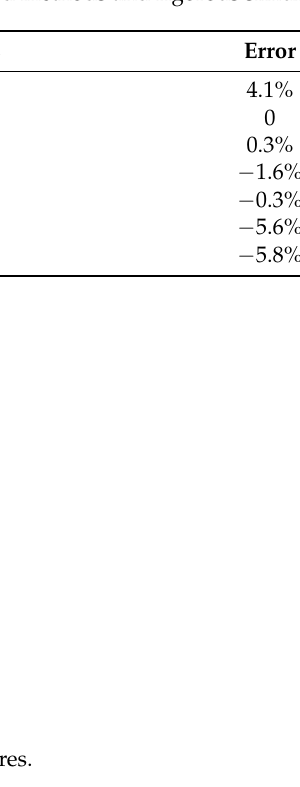
Table 4. Comparison of results obtained by the proposed methods and rigorous simulation.